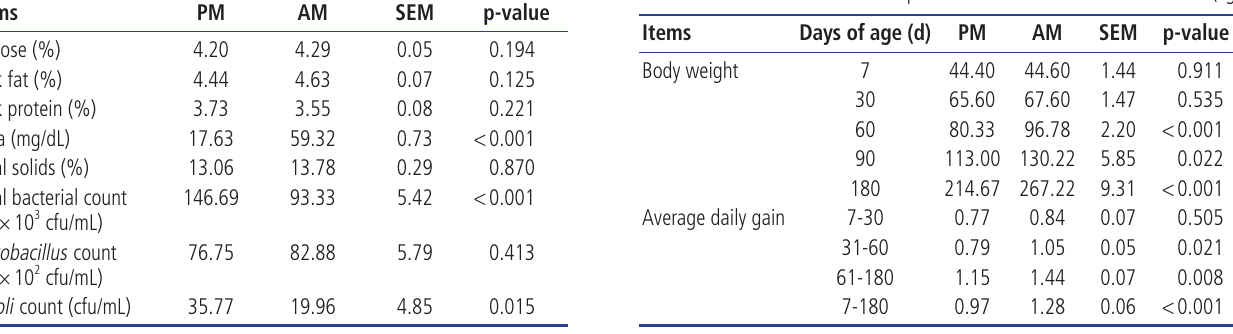
Table 3. Performance of calves fed pasteurized and acidified milk ad libitum (kg)